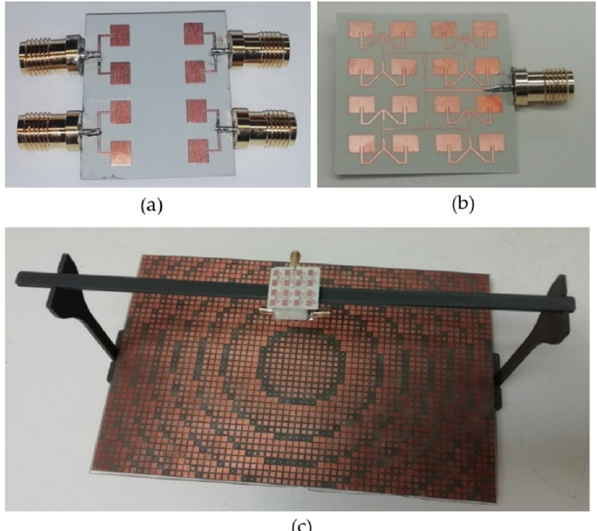
Figure 5. Fabricated ( a ) TX antenna board, ( b ) RX antenna board and ( c ) the reflectarray with the TX and RX antenna assembly.